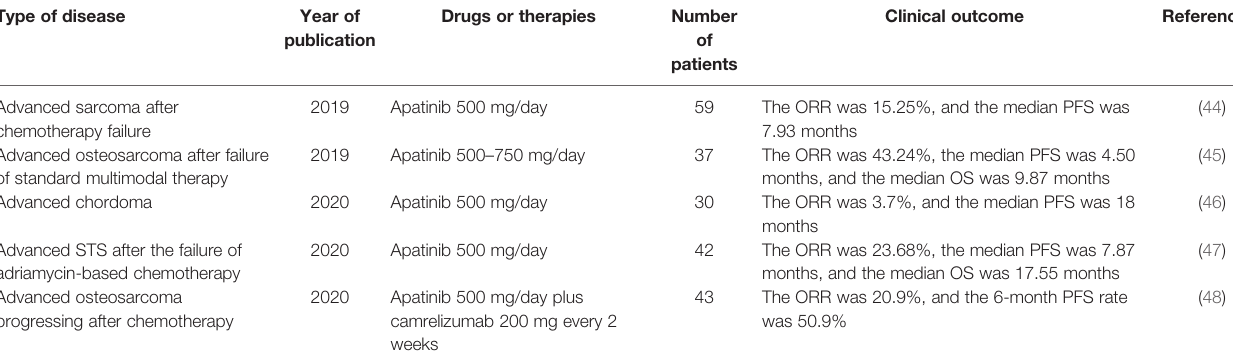
TABLE 4 | Clinical trials on apatinib for sarcoma treatment included in this